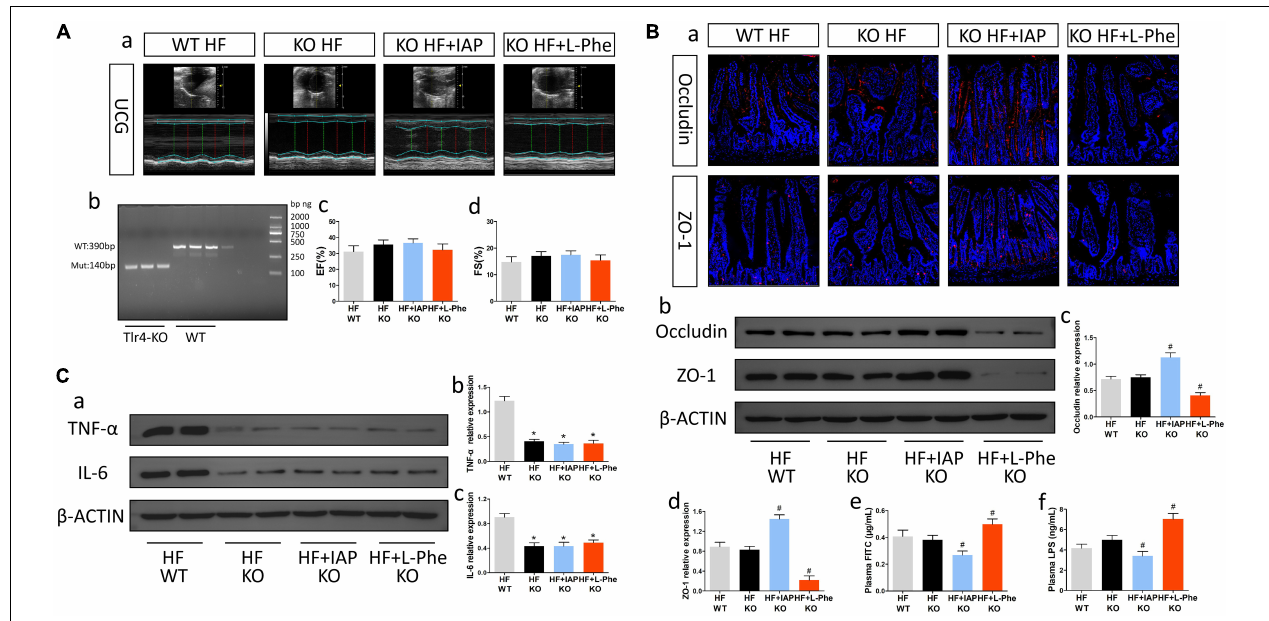
FIGURE 4 | TLR4-KO mice exhibited improvements in neuroinflammation after HF and were not obviously affected by intestinal barrier inhibitors or protectors. (A) Cardiac function in each group. (a) Representative echocardiography tracings. (b) Verification of TLR4 knockout. (c) EF. (d) FS. (B) Intestinal barrier function in each group. (a) Representative immunofluorescent images of anti-occludin and anti-ZO-1 staining in the intestine (magnification, 200 × ). (b) Western blot analysis of the relative levels of Occludin, ZO-1 and the control β -actin in intestinal tissue. (c,d) Quantitative analysis of Occludin and ZO-1 expression. (e) Plasma FITC-dextran concentrations in each group. (f) The levels of plasma LPS in each group. (C) Levels of brain inflammatory cytokines in each group. (a) Western blot analysis of the relative levels of TNF- α , IL-6 and the control β -actin in brain tissue. (b,c) Quantitative analysis of TNF- α and IL-6 expression. * P < 0.05 vs. the WT HF group; # P < 0.05 vs. the KO HF group. EF, ejection fraction; FS, fractional shortening; LPS, lipopolysaccharide; IAP, intestinal alkaline phosphatase; L-Phe, L-phenylalanine.